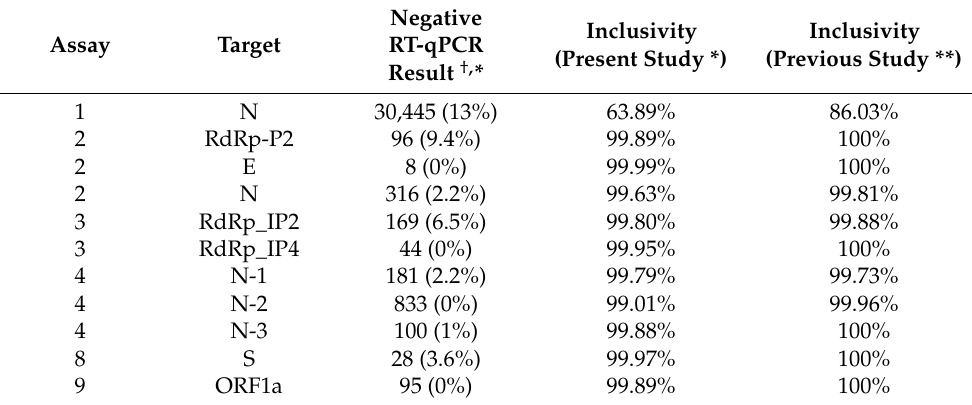
Table 2. Inclusivity evaluation of primers and probe sets using polymeraSe Chain Reaction Evaluation through largE-scale miNing of gEnomic Data